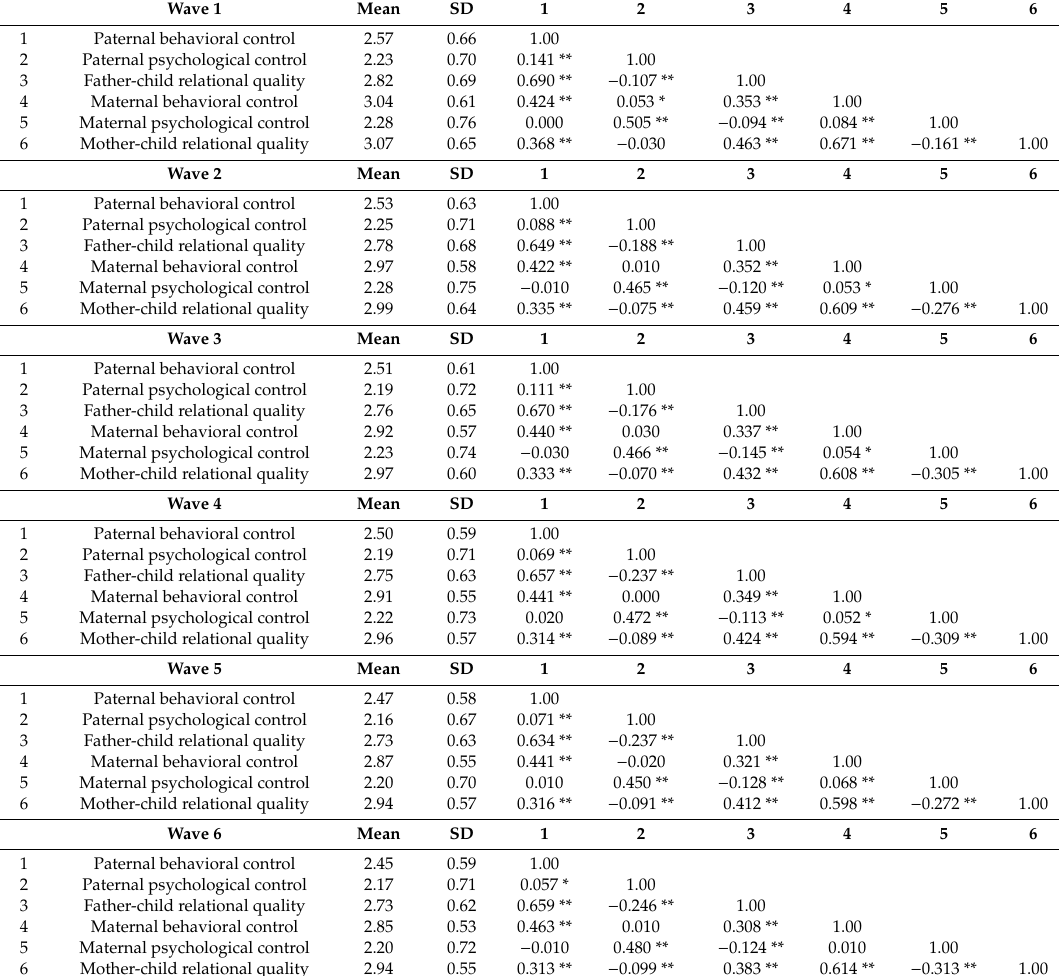
Table A2. Correlations among research